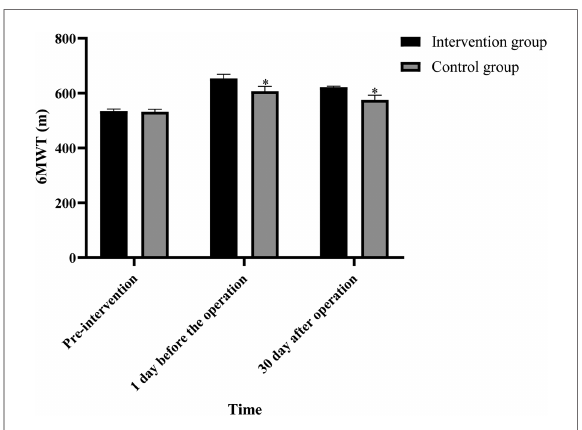
FIGURE 1 Comparison of 6 MWT between the two groups at different times (Note: compared with the intervention group, * P <0.05).